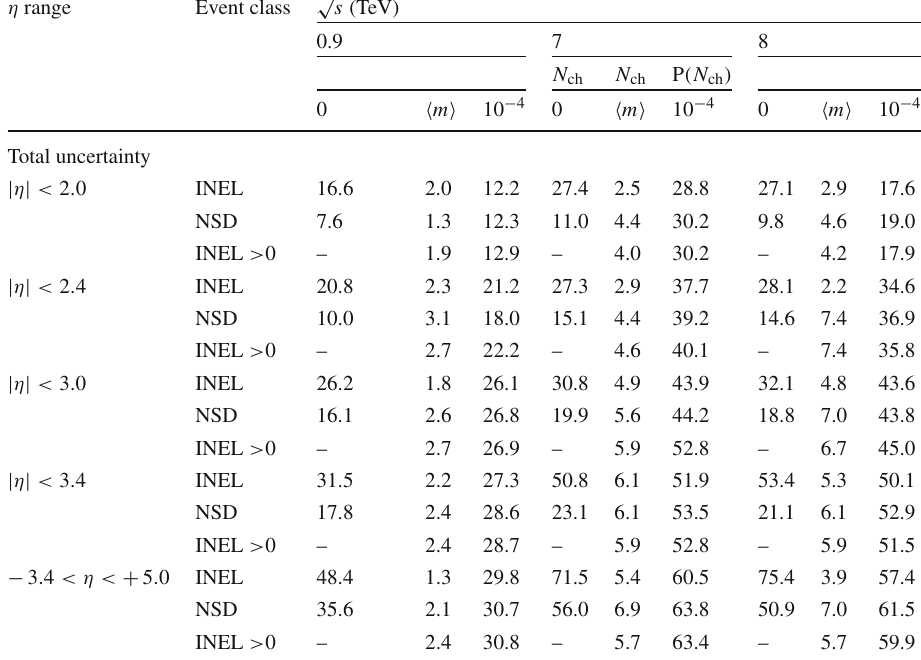
Table 3 Total systematic uncertainties (in percent), for the INEL, NSD and INEL > 0 event classes. Numbers are given at multiplicity values of 0, the mean (cid:3) m (cid:4) , and